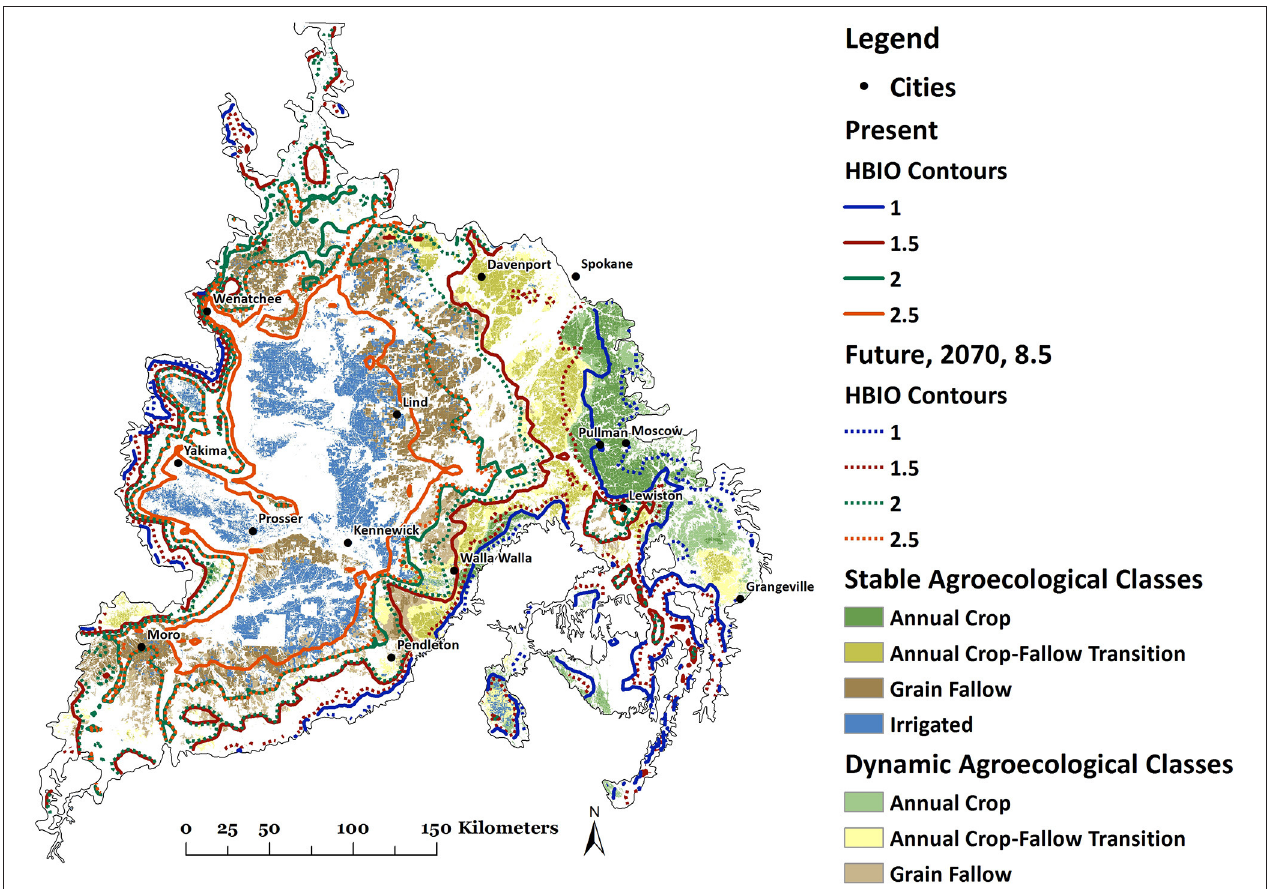
FIGURE 2 | Geo-spatial depiction of current Agro-ecological classes (AECs) and Holdridge Evapotranspiration index (HBIO) in present (1981–2010) and future climate scenario (2070, Representative Concentration Pathway,